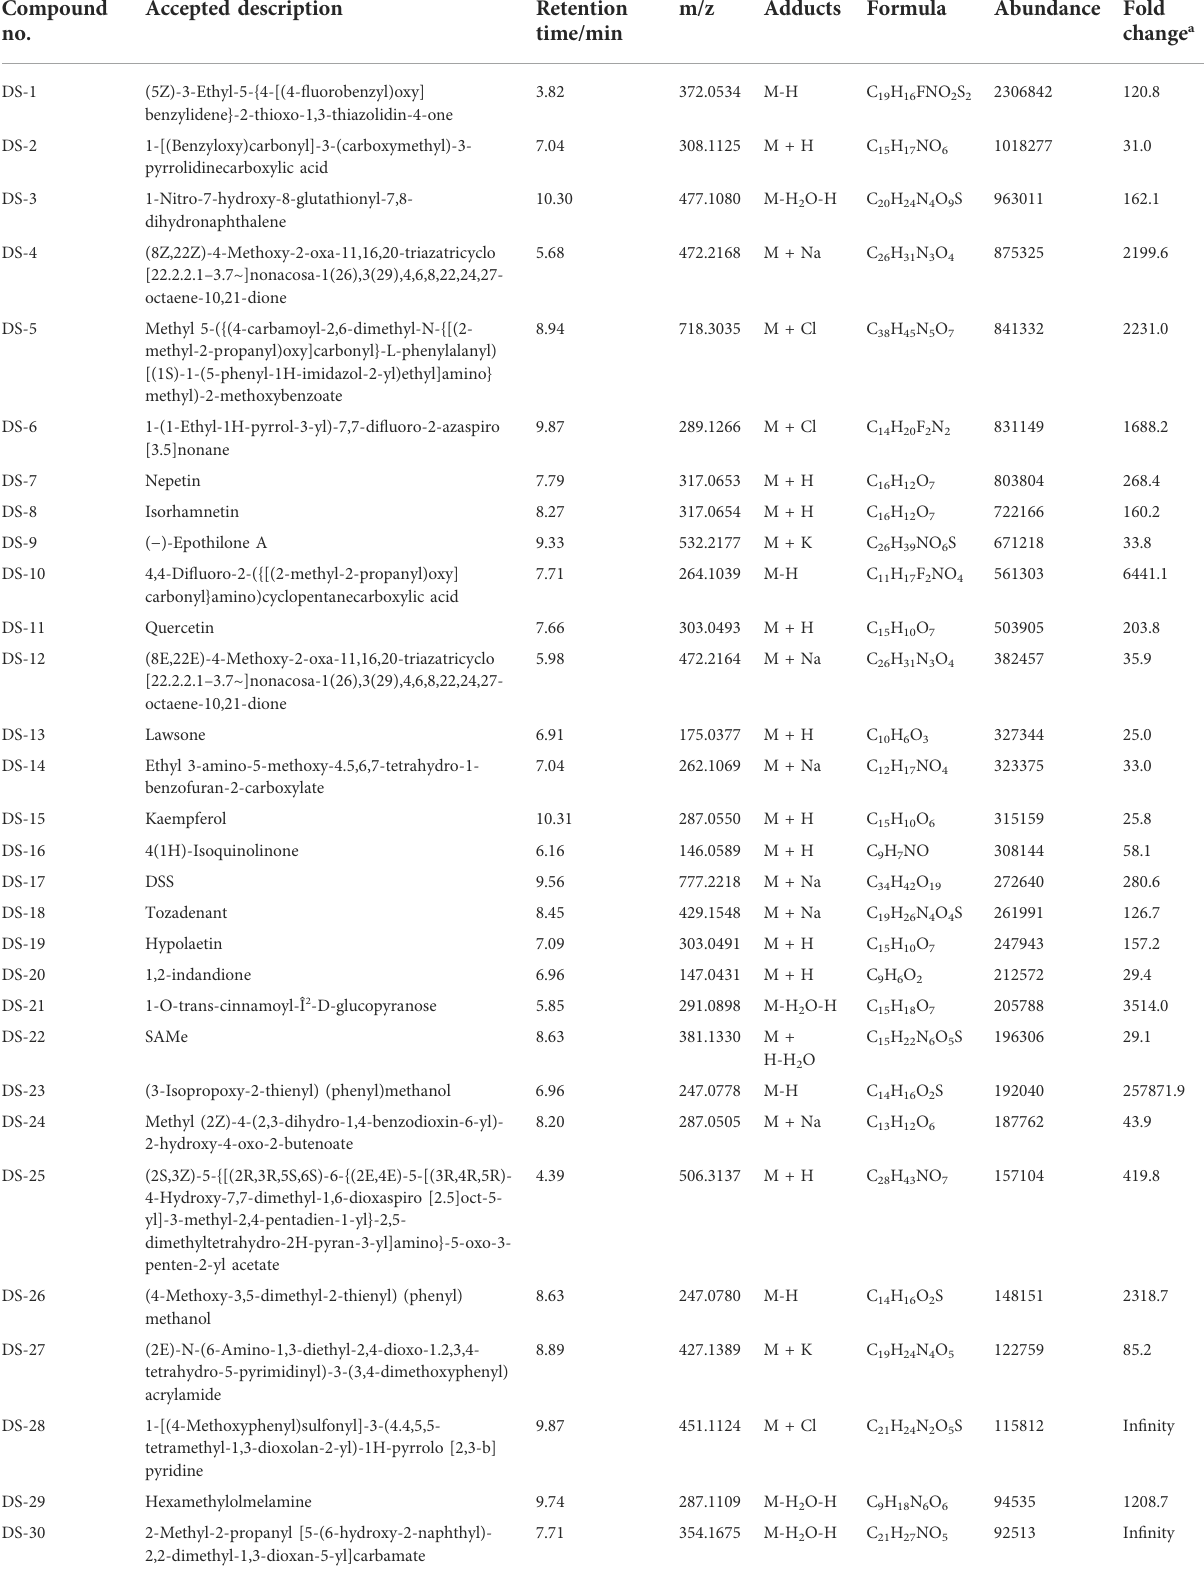
TABLE 1 Components identi fi ed in Descurainia sophia seed decoction. Compound